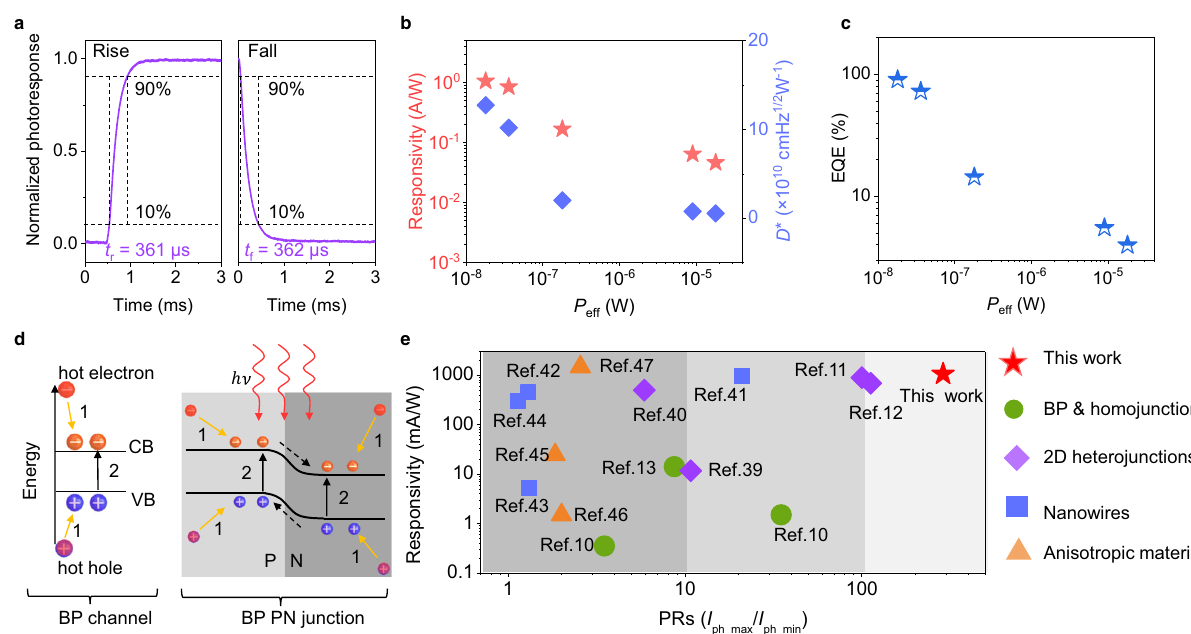
Fig. 5 Optoelectronic measurement at a wavelength of 1450 nm. a 90 – 10% rise ( t r ) and decay ( t f ) time of photocurrent are measured as 361 and 362 μ s, respectively. b , c Calculated responsivity ( R ), detectivity ( D * ), and external quantum ef fi ciency (EQE) with effective incident optical powers ( P eff ). d The carrier multiplication process in BP channel and BP PN junction. The orange and blue spheres represent electron and hole, respectively. The orange and black arrows represent step 1 and stpe 2. The black dashed arrows represent the fl ow direction of carriers. e Responsivity and PRs of BP in-plane PN homojunction de fi ned by ferroelectric domains outperform most of previously polarization photodetectors, including BP, BP homojunctions de fi ned by other methods, 2D heterojunctions, nanowires, and other anisotropic mapping at 520 nm incident light, and the inset is the optical